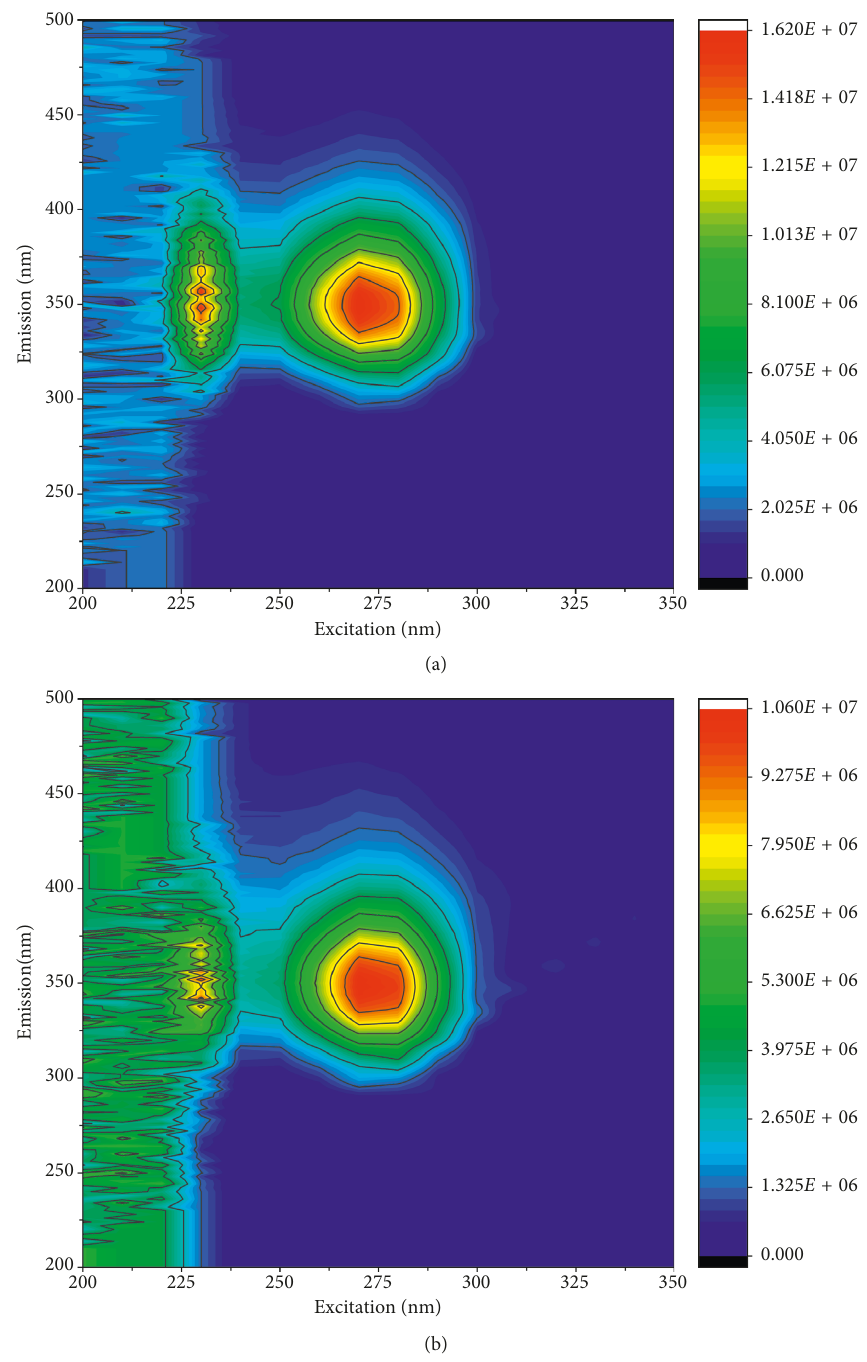
Figure 4: Excitation-emission matrix spectra of (a) free HSA (1 µ M) and (b) HSA with the coumarin derivative complex (1 µ